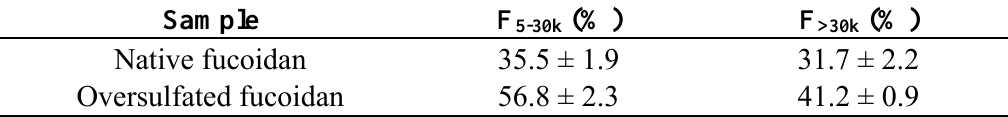
Table 1. The sulfate contents of native and oversulfated fucoidans.